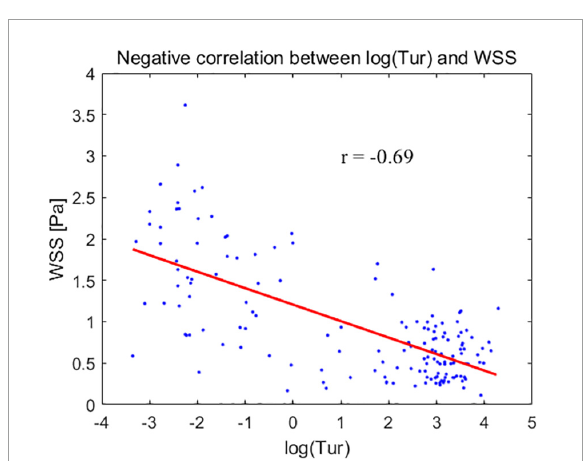
FIGURE5 The modified mean values of turbulence index (Tur) – log(Tur) (horizontal axis) for the common carotid artery, subclavian artery, and common femoral artery correspond to the mean wall shear stress (WSS) (vertical